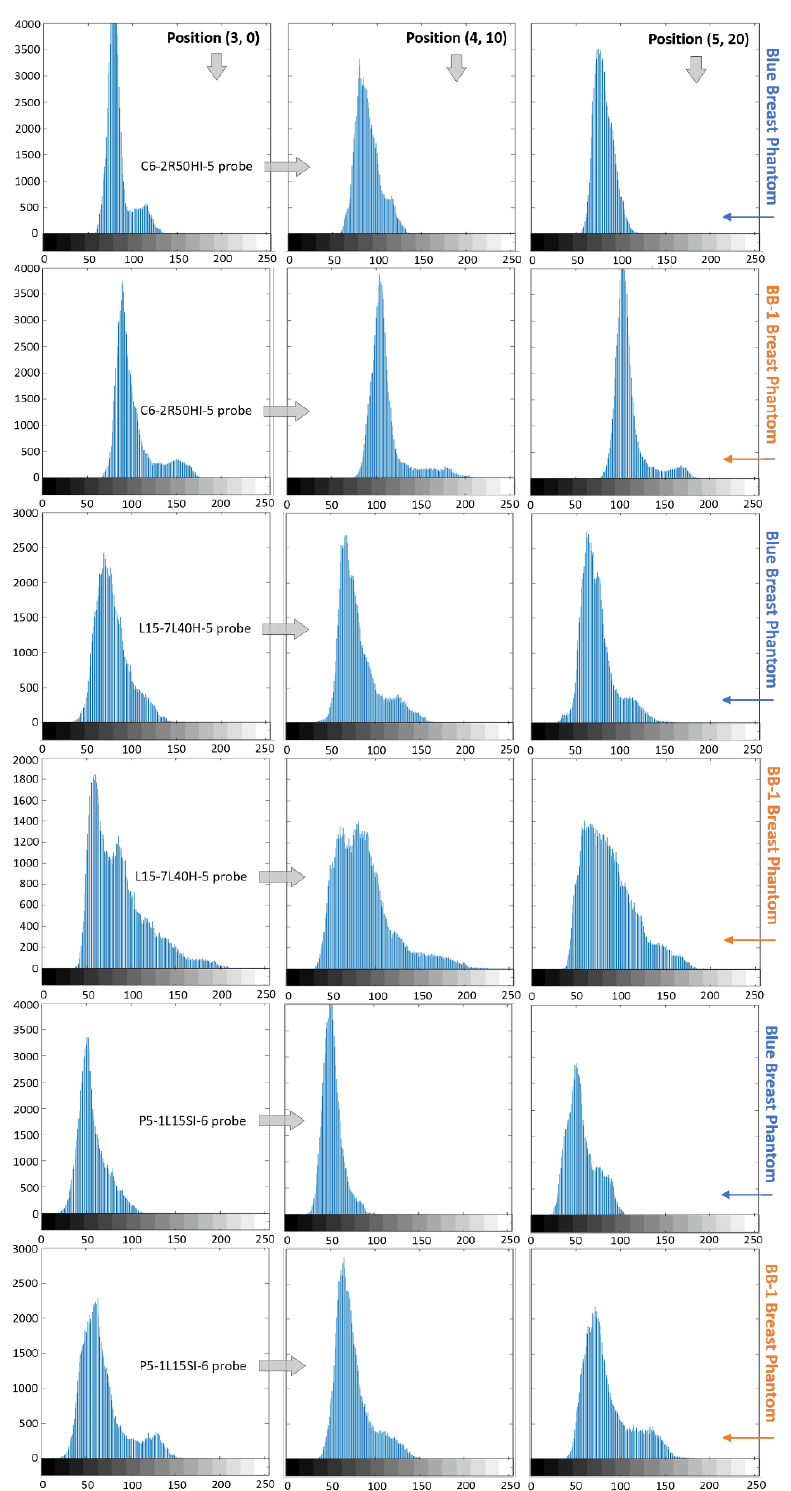
Figure 12. Histogram of ROI of the planes obtained with 3 different types of probe (rows) in 3 different positions (columns) relative to 2 measured breast phantoms: Blue and BB-1, as indicated along the arrows.